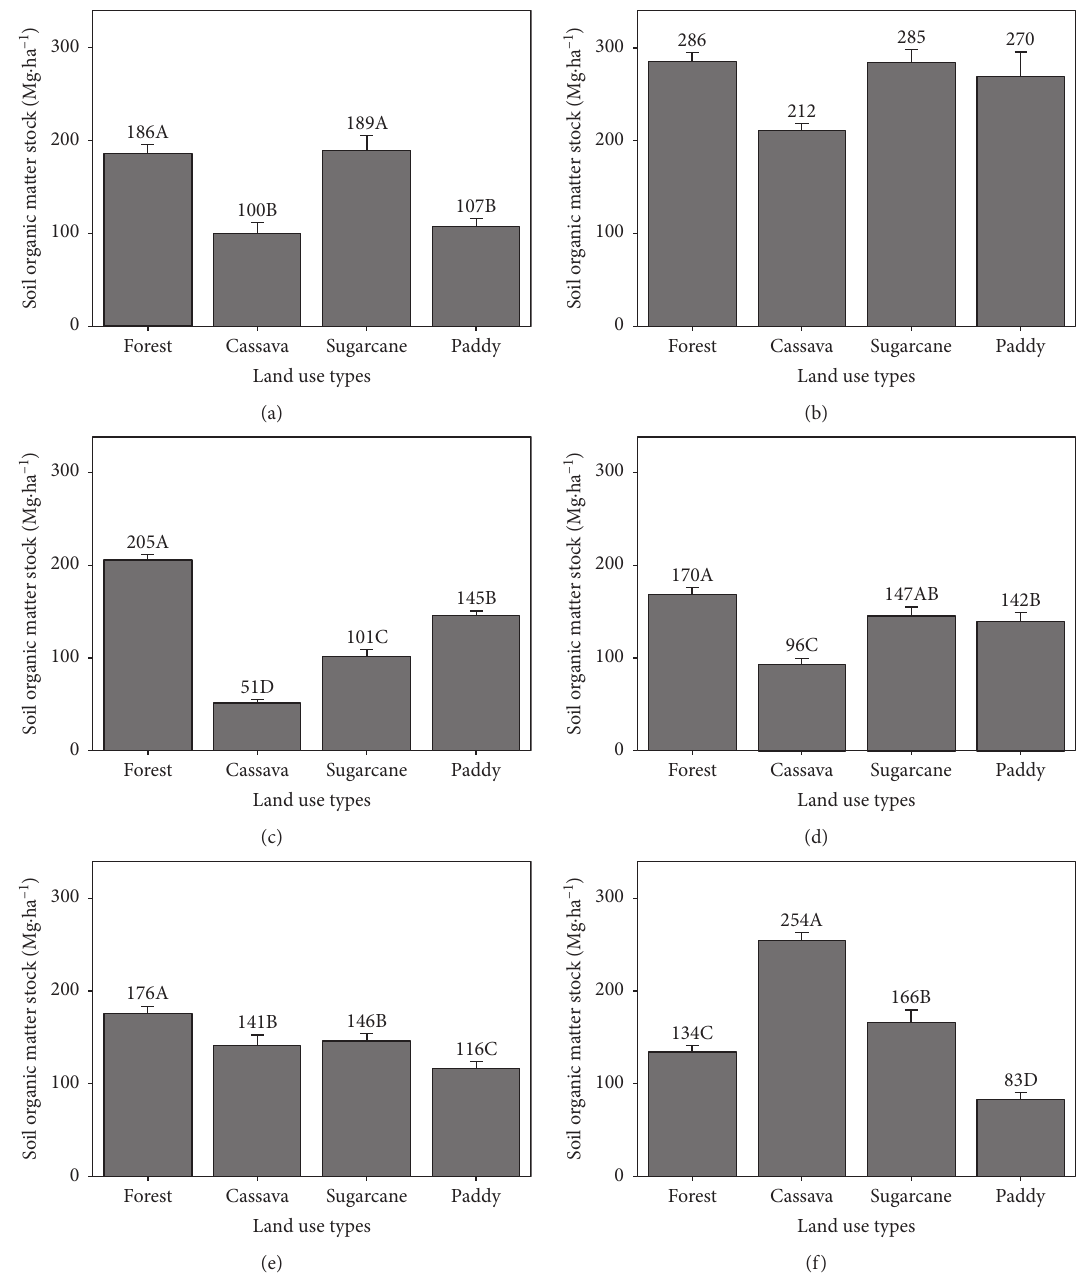
Figure 4: Land use changes affecting SOM stocks in whole soil profile (0–100cm) in six locations. Uppercase letters accompanying bar graphs denote comparisons of SOM stocks among different land uses. Similar letters indicate no significant differences ( P > 0 . 05), as analysed by the LSD method. Error bars represent standard error of the mean. (a) Muang. (b) Kantharawichai. (c) Kosum Phisai. (d) Kut Rang. (e) Borabue. (f) Wapi